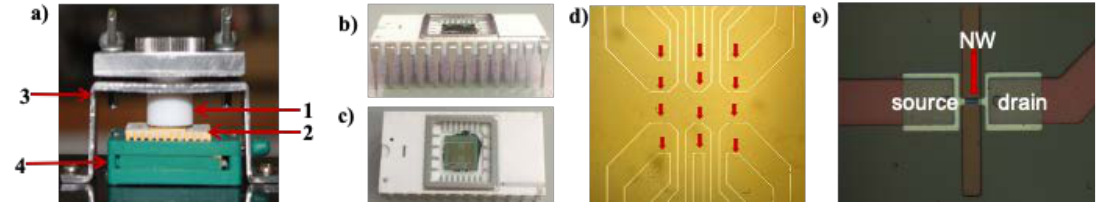
Figure 1. Photographic images ( a – c ) and optical microscopy ( d,e ) images of the nanowire (NW) biosensor components. Panel ( a ) displays the overall image of the assembled analytical module; arrows indicate: the silicon-on-insulator (SOI)-NW chip with an array of nanowires (1); chip holder (2); measuring cell holder (3); measuring cell (4). Panels ( b ) and ( c ) display the images of a framed NWchip (front view and side view). Panel ( d ) displays the surface of the chip with an array of nanowires. Panel ( e ) displays the image of a single nanowire (NW) and the ohmic contacts.